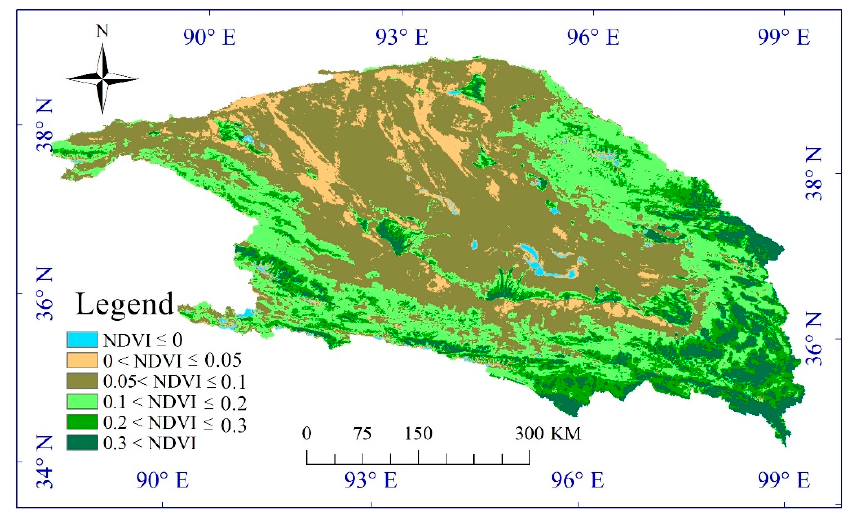
Figure 4. The spatial distribution of the average growing season NDVI from 2001 to 2016.